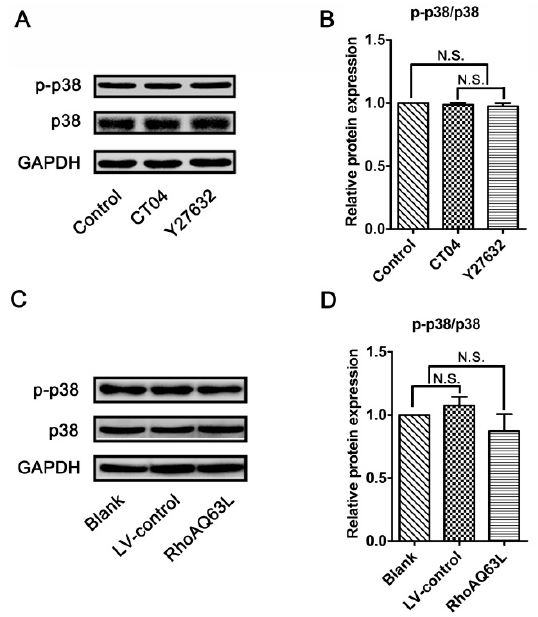
Figure 7. The RhoA signaling pathway does not alter the expression and activation of p38 MAPK in neuronally differentiated PC12 cells. ( A – D ) Western blots showed that the levels of total p38 MAPK (p38) and phosphorylated p38 MAPK (p-p38) were not significantly regulated by CT04, Y27632 treatments, or the overexpression of constitutively activated RhoA (RhoAQ63L). The protein level in the control group was normalized to 1. The data are shown as the mean ± SEM values (N.S. indicates nonsignificance).